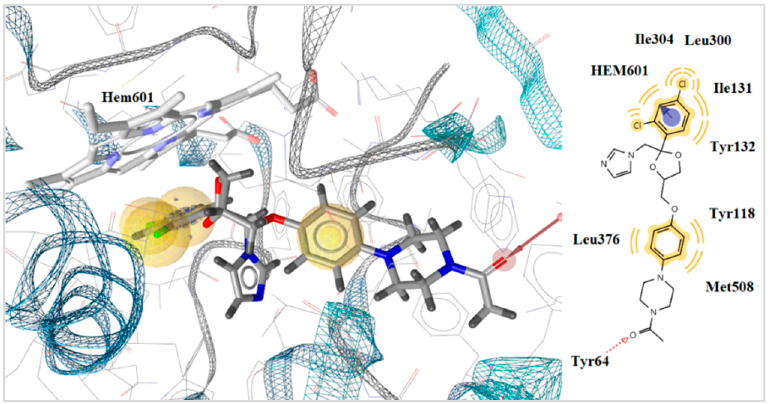
Figure 2. Docked conformation of ketoconazole in lanosterol 14 α -demethylase of C . albicans (CYP51 ca ).